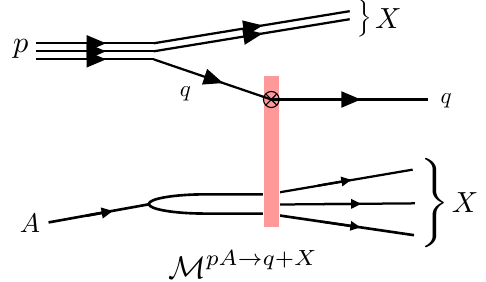
pA q + X for quark production in proton-nucleus → M